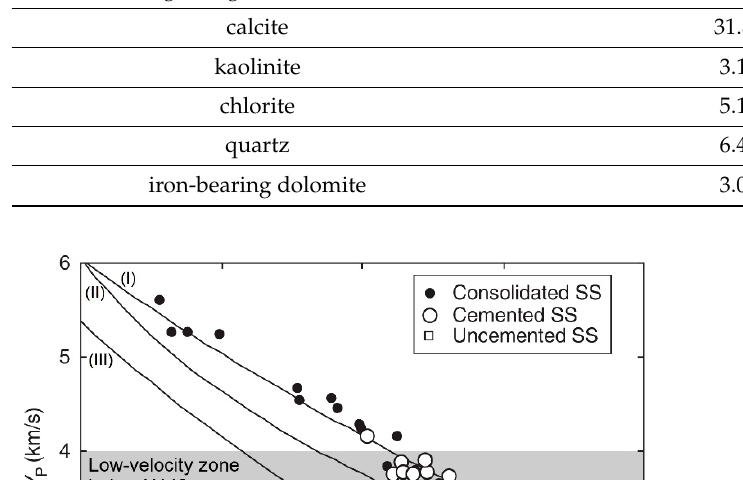
Table 2. Minerals of representative samples (Figure 10a) from H110, analyzed using X-ray diffraction. Mineral Ratio illite 14.50% high-magnesian calcite